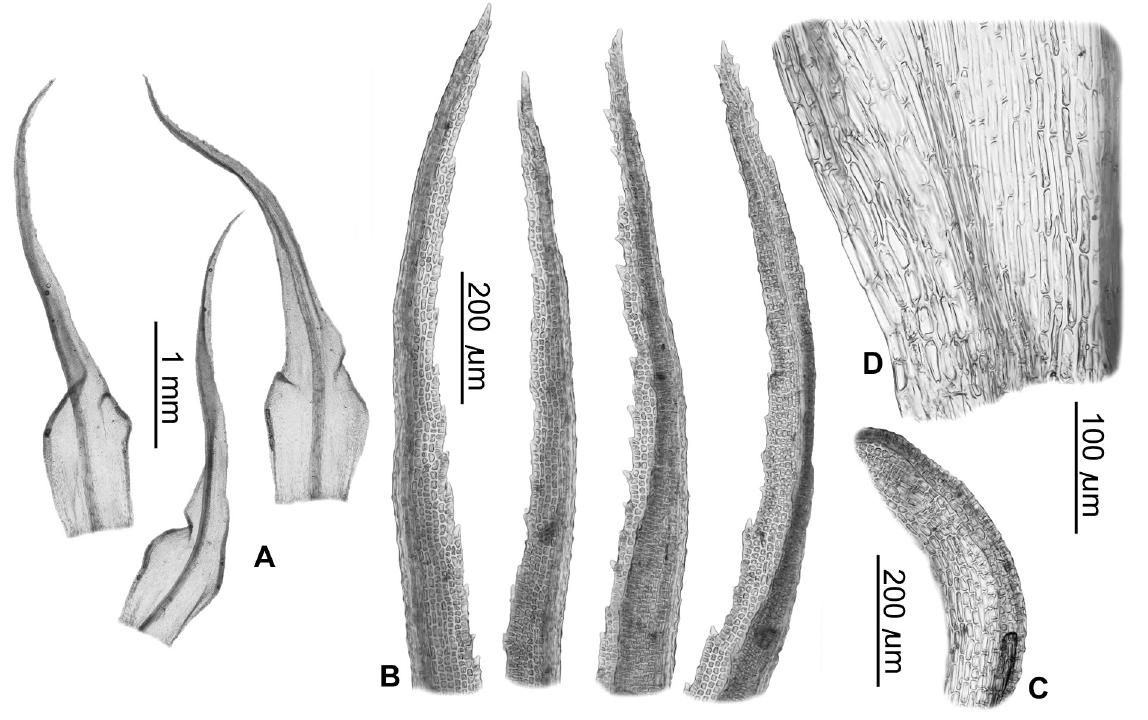
Fig. 9. Oncophorus virens (specimen P286; cf., Table 1). A . Stem leaves. B . Upper leaf acumen. C . Portion of leaf at widest point, showing the broadly recurved margin. D . Lower part of sheathing leaf portion, showing differentiated alar region (margin to the